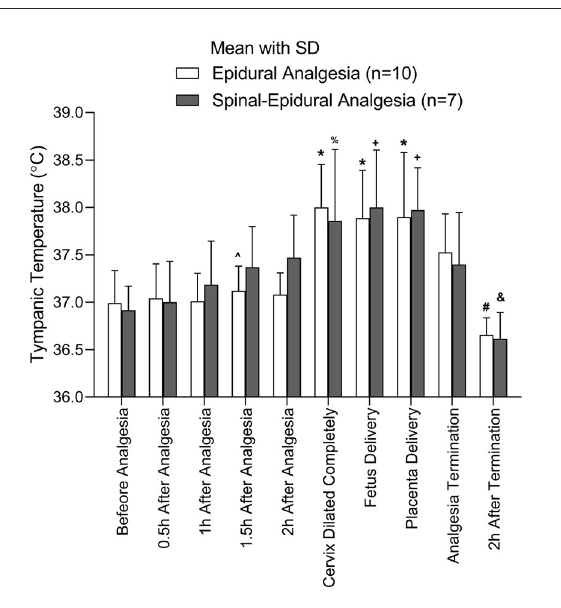
FIGURE3 The temperature changes over different events